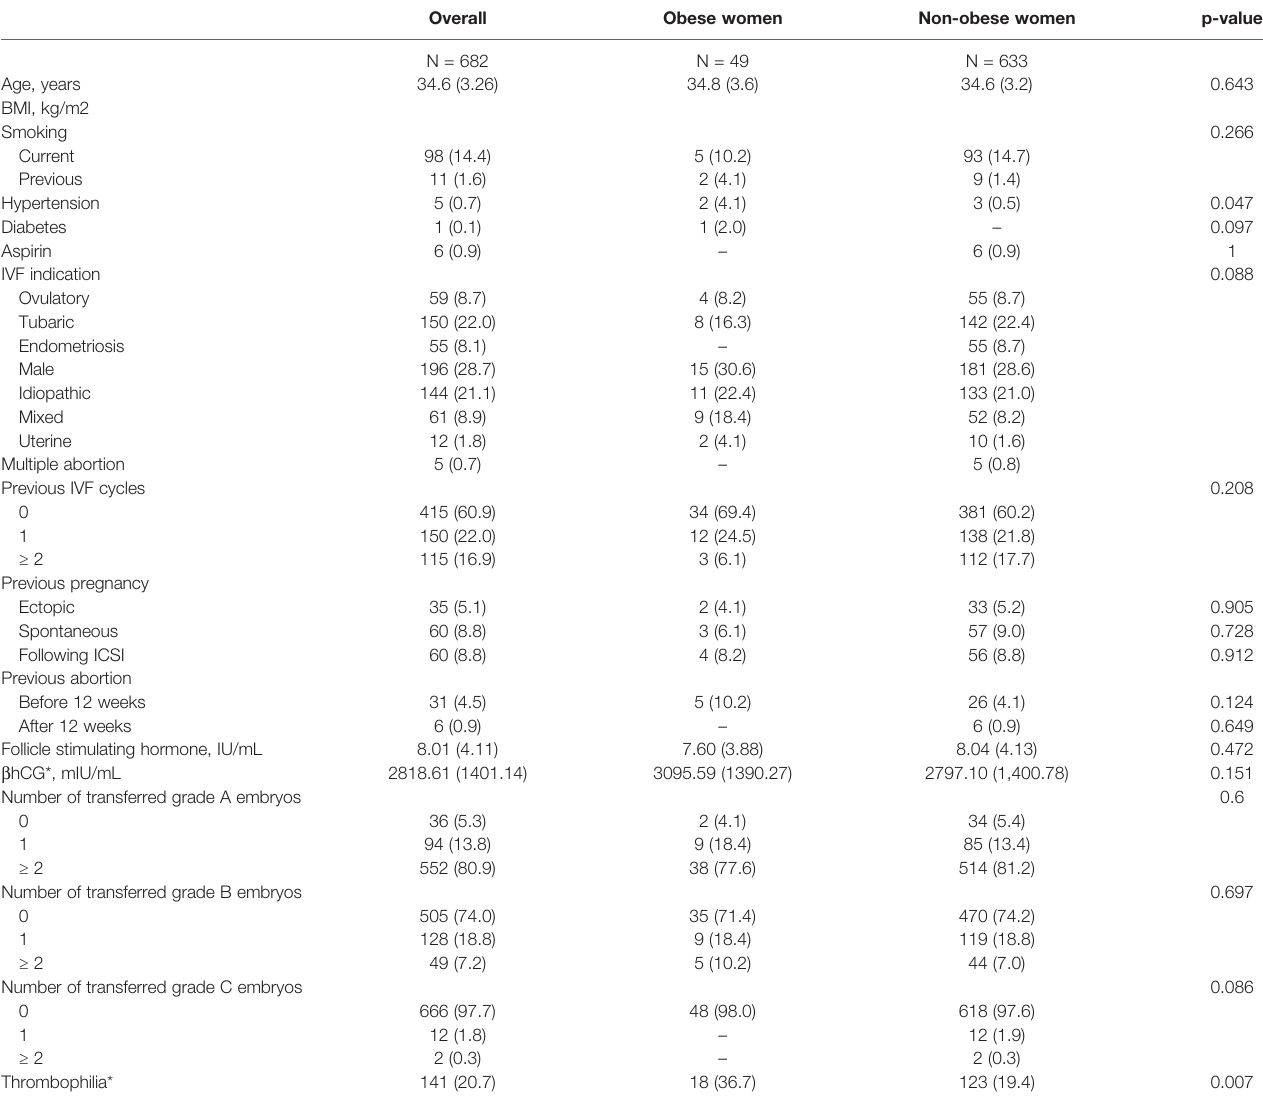
TABLE 1 | Baseline characteristics of study